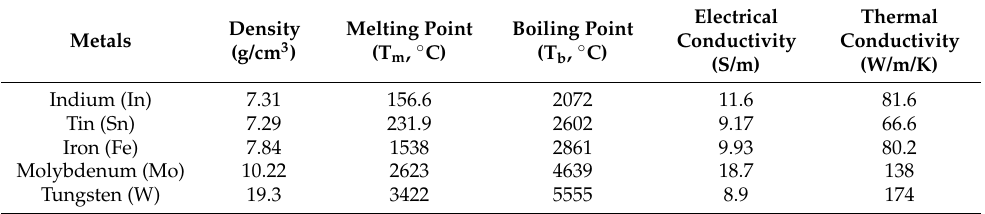
Table 4. Physical properties of some metals (M) produced by aluminum/metal oxide (MO) energetic composite